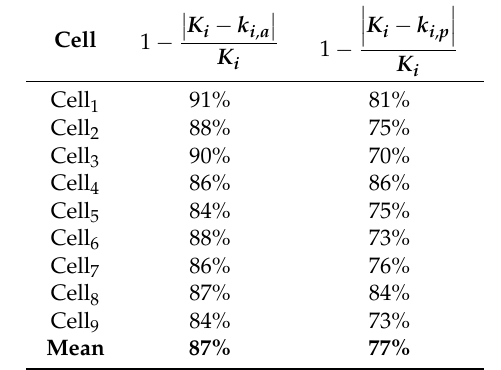
Table 5. The accuracies of traffic density estimation of each road